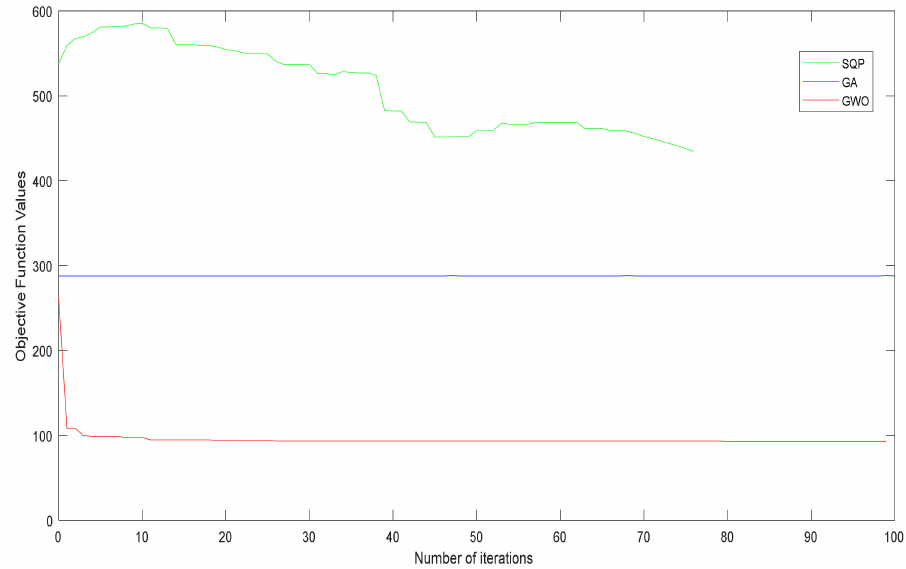
Figure 16. Convergence characteristics of the optimization algorithms used for the 12-DOF model (combined